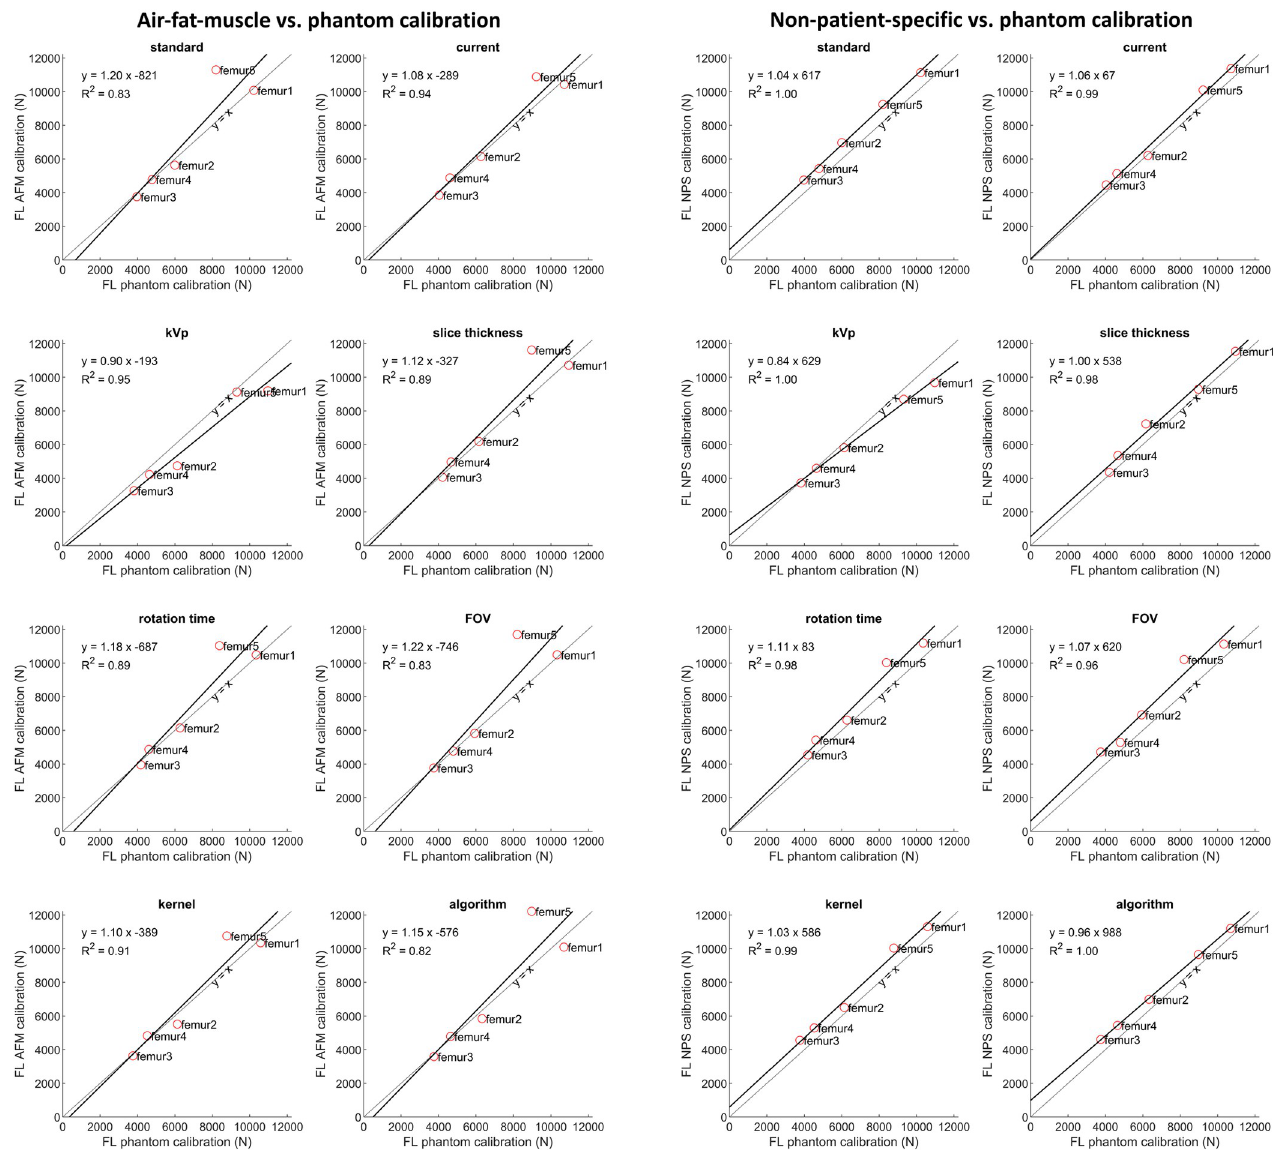
Fig 6. Correlation between failure loads after phantom and air-fat-muscle calibration and phantom and non-patient-specific calibration. Solid lines show the best-fit lines for each protocol.